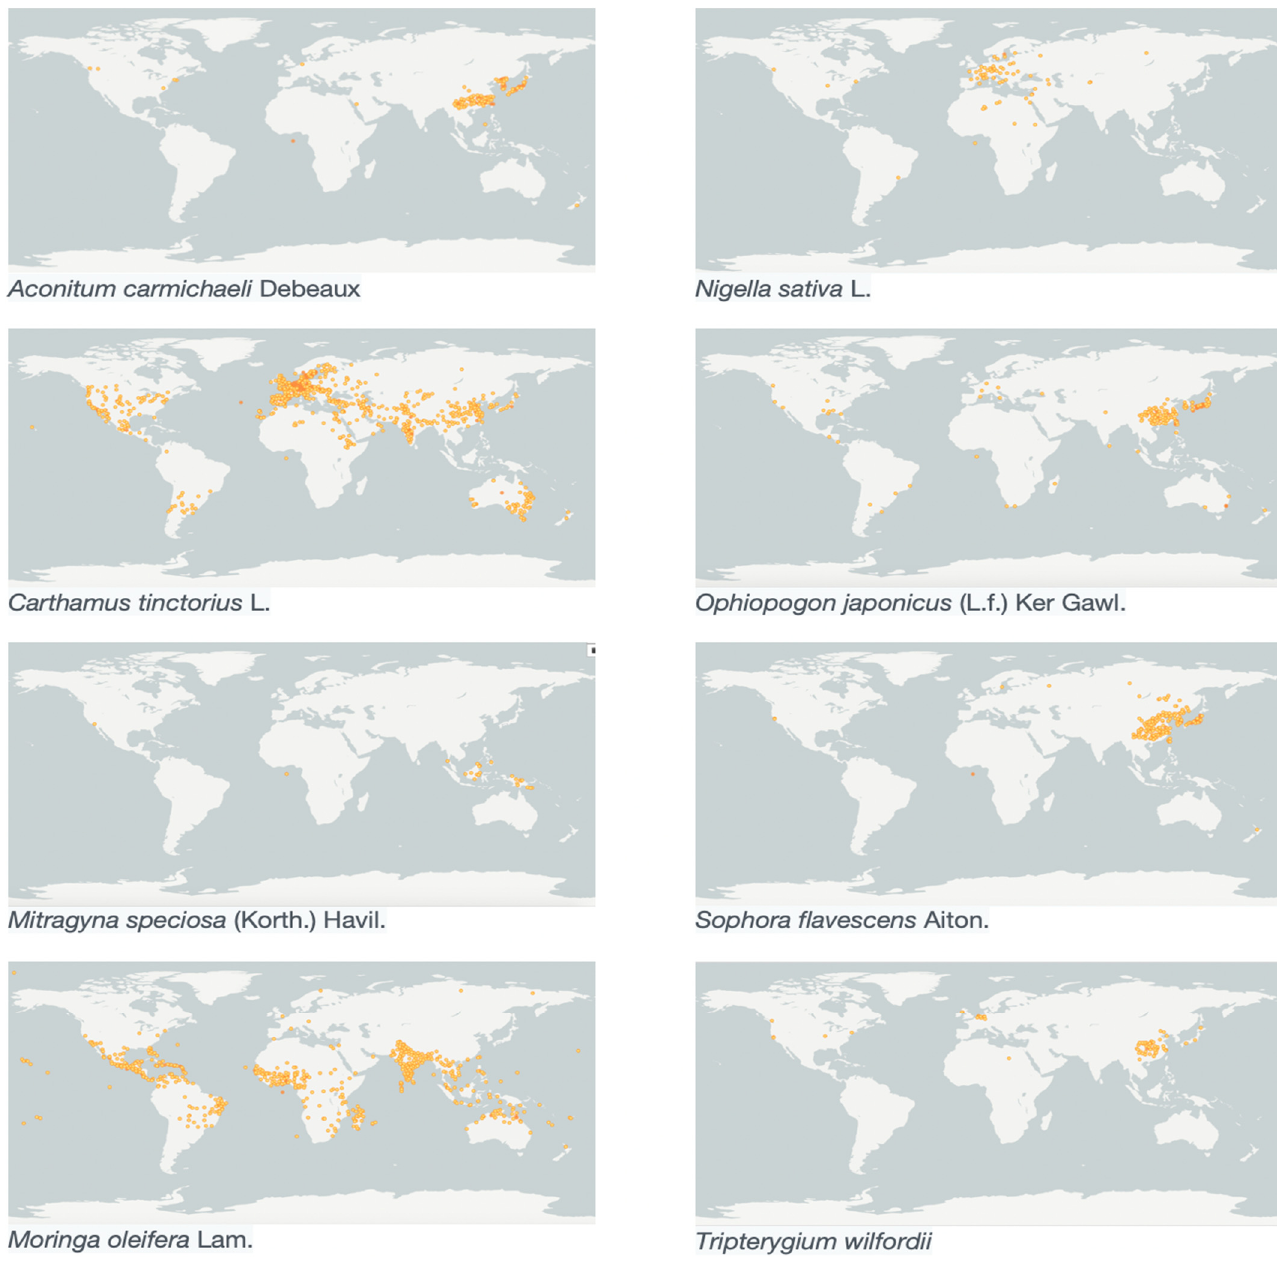
Figure 2. Geographical distribution of species used as supplements/botanicals containing alkaloids as bioactive substances. The intensity of orange areas demonstrates the level of abundances in the indicated area.